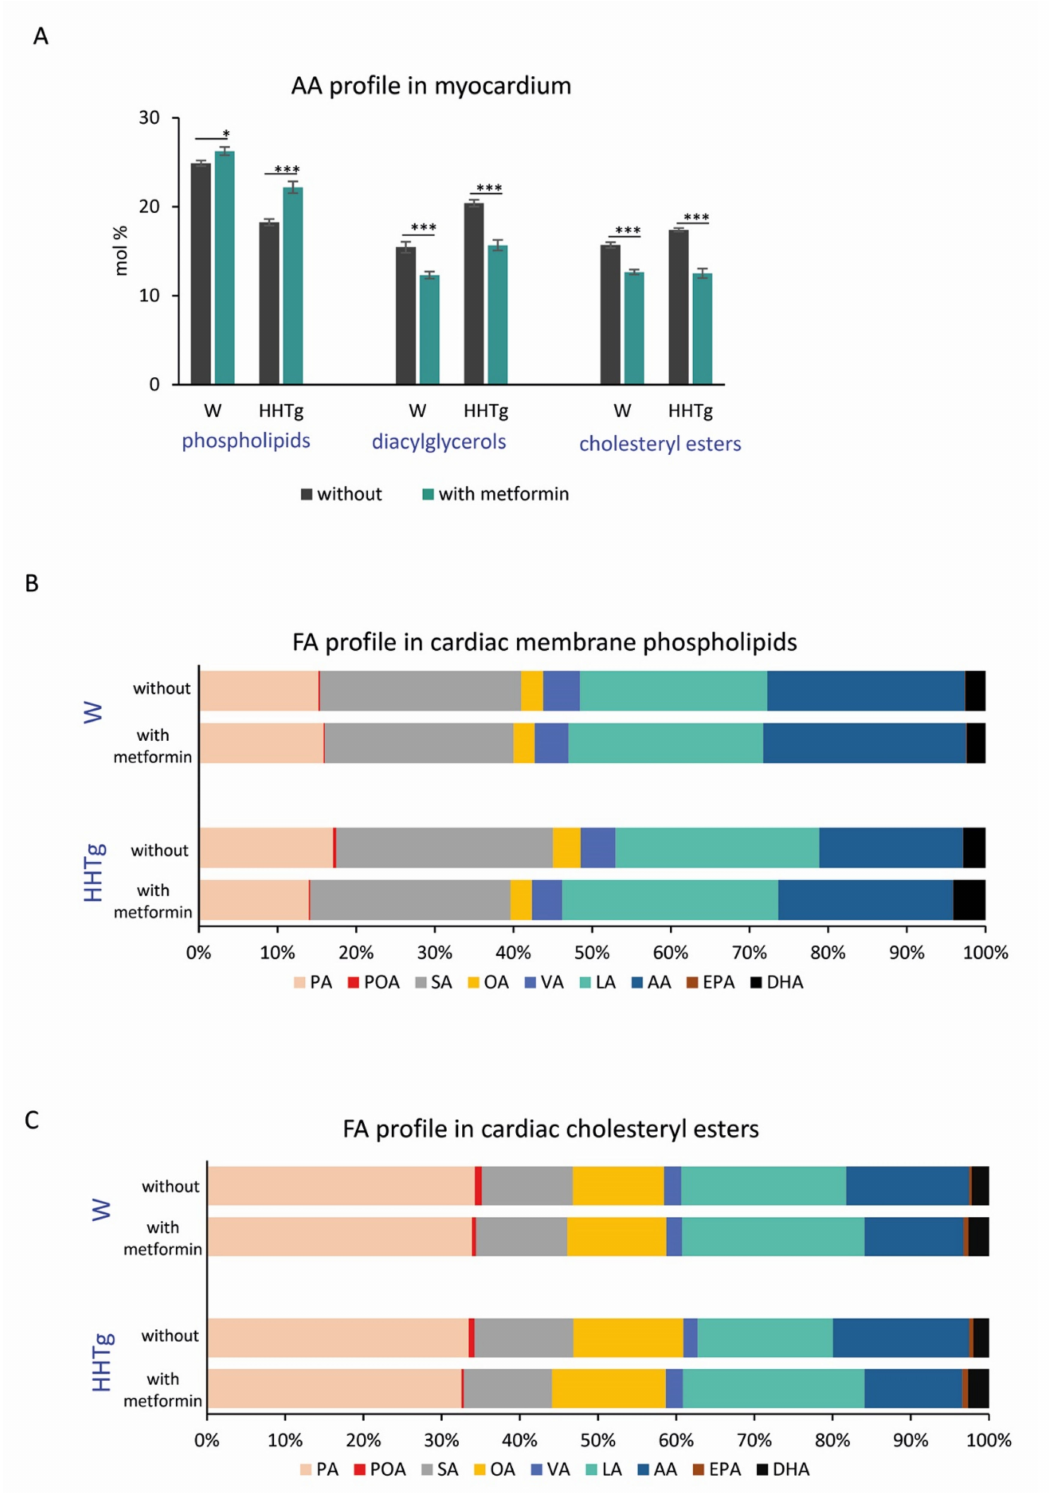
Figure 4. Effects of metformin on arachidonic acid profile in myocardial phospholipids, diacylglycerols and cholestryl esters ( A ), fatty acid profile in myocardial phospholipids ( B ) and cholesteryl esters ( C ) in Wistar control (W) and hereditary hypertriglyceridemic (HHTg) rats; n = 8 for each group. Significance was determined using two-way ANOVA and Fisher’s LSD post-hoc test (* denotes p < 0.05; *** denotes p < 0.001). PA—palmitic acid, POA—palmitoleic acid, SA— stearic acid, OA—oleic acid, VA—vaccenic acid, LA—linoleic acid, AA—arachidonic acid, EPA—eicosapentaenoic acid, DHA—docosahexaenoic